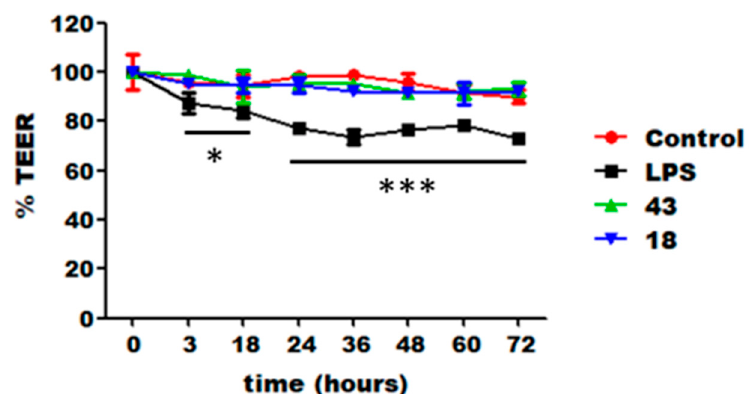
Figure 6. Evaluation of cell monolayer permeabilization as transepithelial electrical resistance (TEER) assay. Caco-2 cell monolayers were incubated with LPS at 1 µ g/mL (black squares) as negative control, compound 18e at 20 µ M (blue triangles), compound 43a at 20 µ M (green triangles), and Control (red circles) as positive control. Statistically significant differences are expressed as follows: * = p < 0.05 LPS/Control; *** = p < 0.001 LPS vs. Control. Each value represents the mean ± SD of independent experiments ( n = 3).